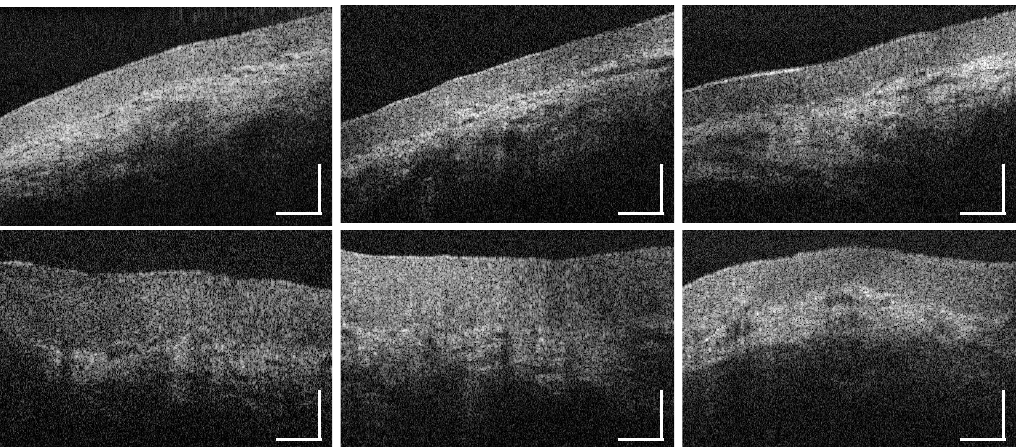
Figure A13. Supplementary intensity-based OCT cross sections of the mucosal tissue of the central inner lower lip (MP3, Figure 1). Scale bars: 200 µ